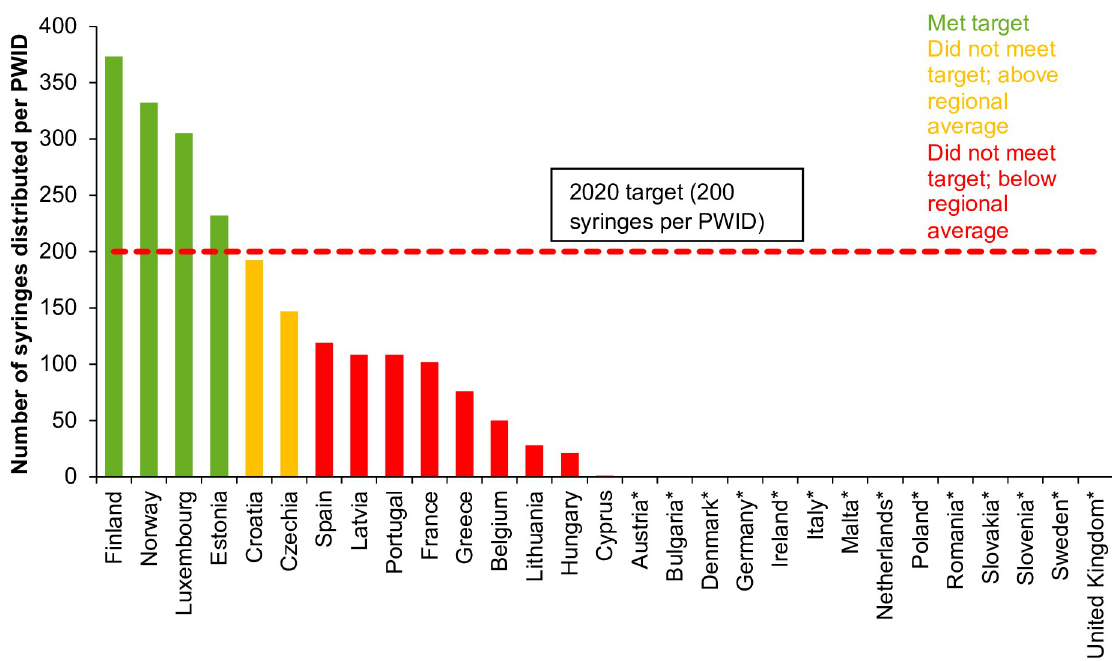
Fig 2. Estimated number of syringes provided per person who injects drugs in 2017 or most recent year with available data [11] �� . � No data from Austria, Bulgaria, Denmark, Germany, Ireland, Italy, Malta, the Netherlands, Poland, Romania, Slovakia, Slovenia, Sweden and the United Kingdom. �� Iceland and Lichtenstein were not surveyed in this source of data.